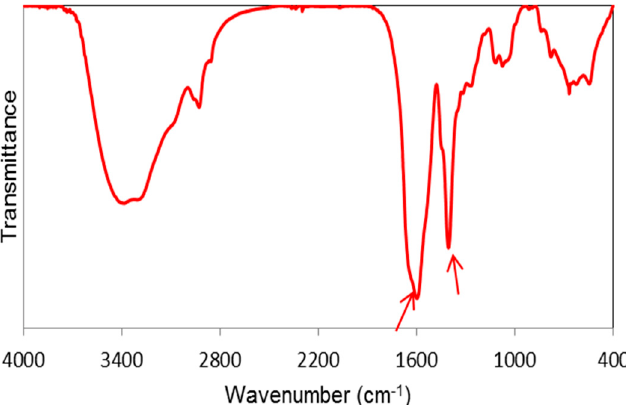
Figure 1. Fourier transform infrared (FT ‐ IR) spectra of poly ‐ gamma ‐ glutamic acid ( γ‐ PGA). The arrows indicate typical absorptions of carboxylic group.